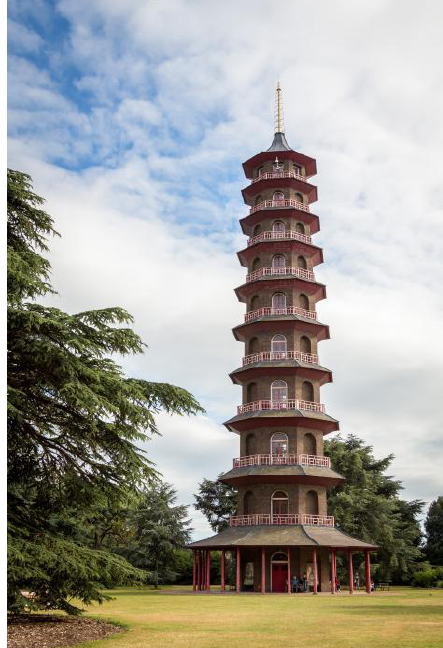
Figure 1. Kew Gardens Great